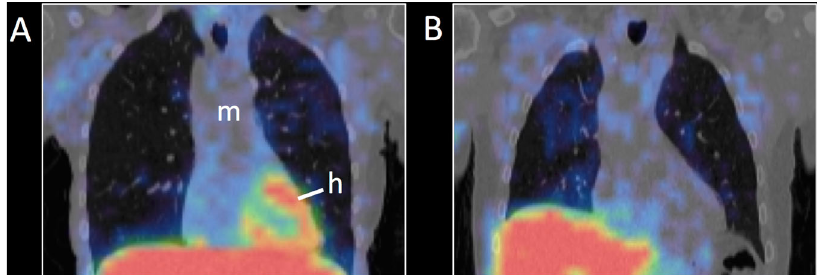
Fig. 1 123 I-MIBG SPECT images superimposed on anatomical CT. a Healthy subject with normal cardiac uptake. b PD patient with severely decreased cardiac uptake. [h heart, m